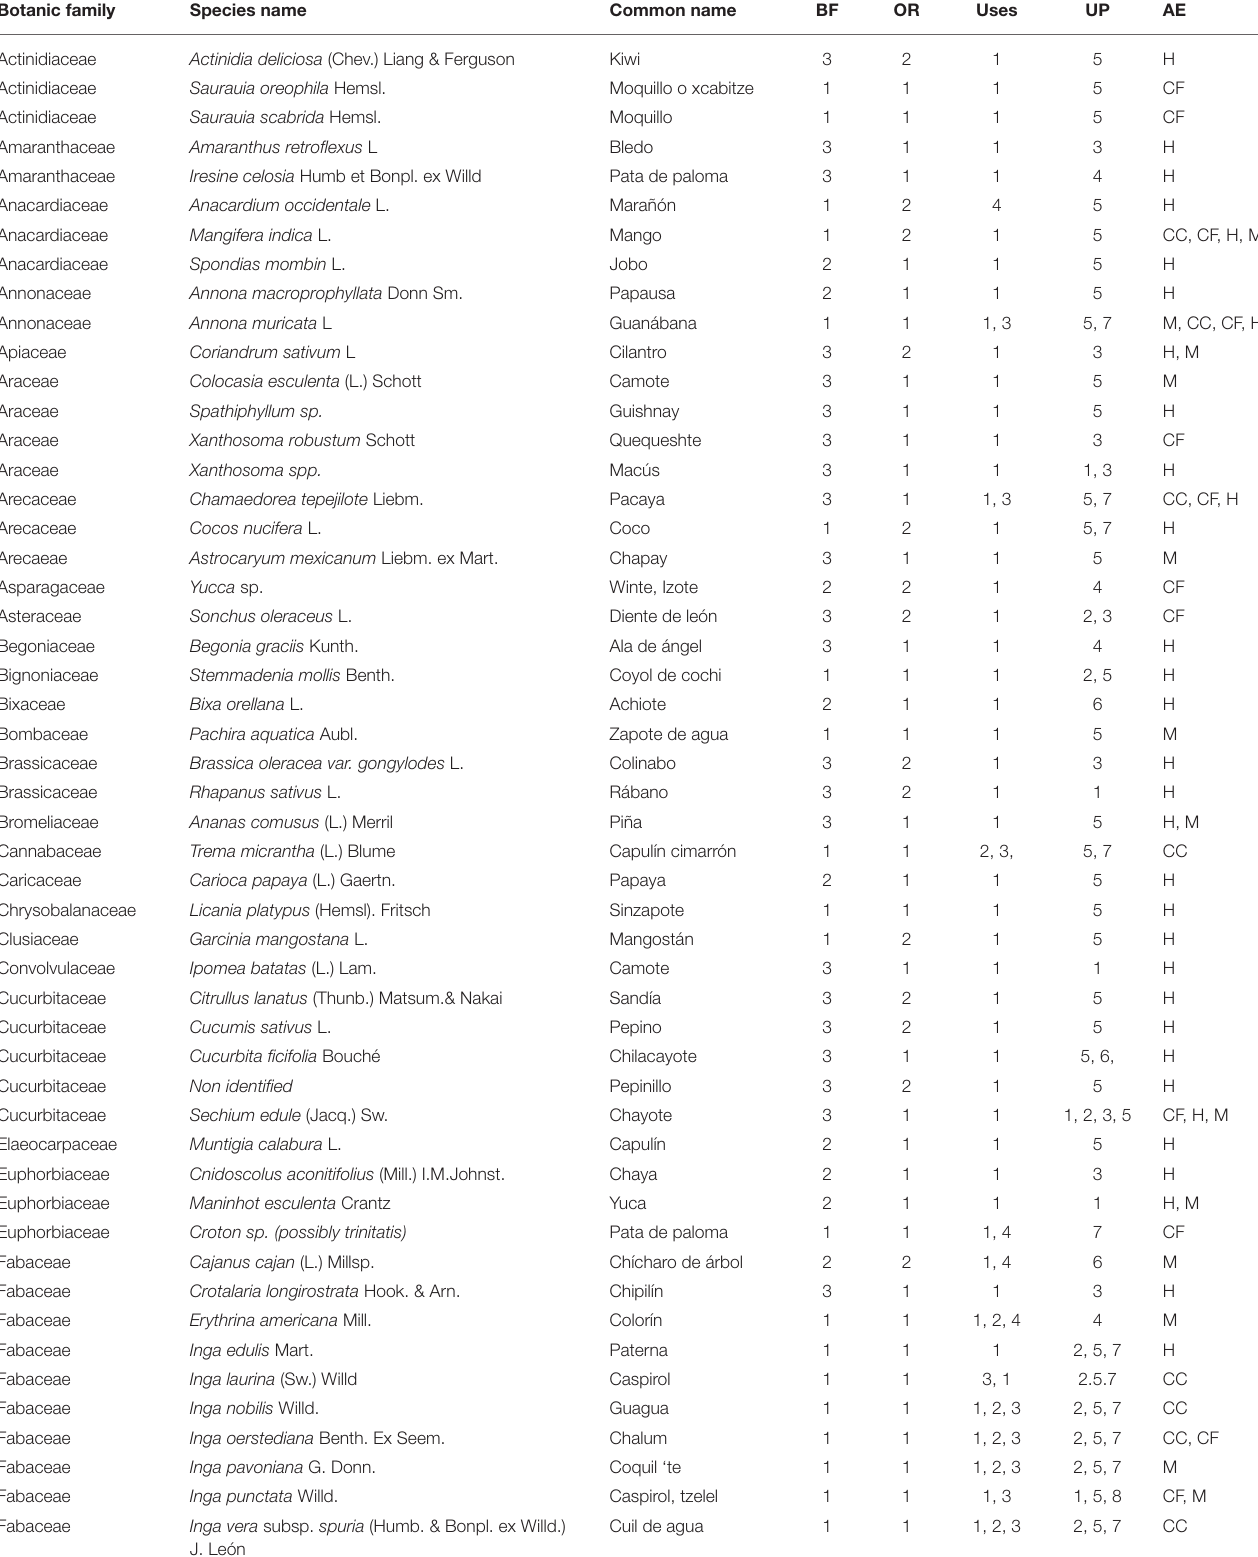
TABLE 1 | Species recorded in four AFS: milpa, homegardens, coffee and cocoa in Chiapas. Botanic